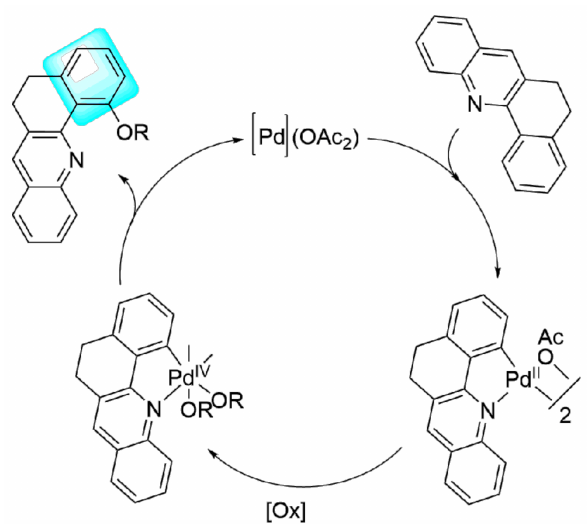
Figure 4. Possible mechanism for palladium-catalyzed regioselective